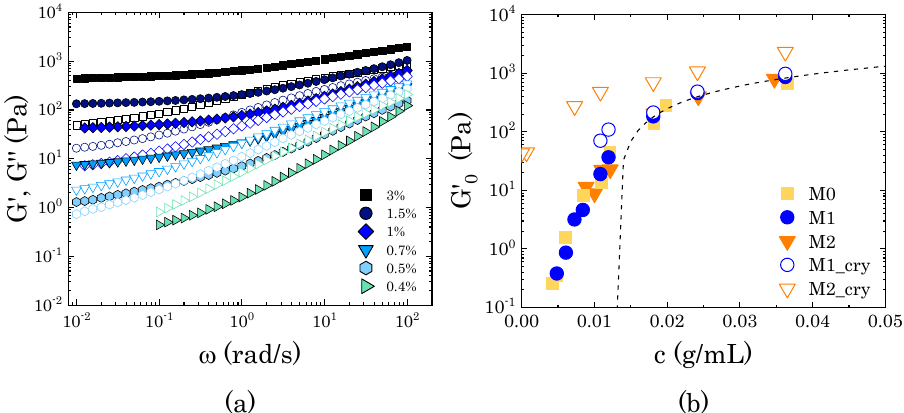
Figure 5. ( a ) Frequency dependence of the storage (closed symbols) and loss (open symbols) moduli at increasing Carbopol concentration. The data refer to samples M0, but the same behaviour was observed for regenerated M1 and M2 solutions. ( b ) Storage modulus, sampled at 1 rad/s, as a function of Carbopol concentration for samples M0, M1, and M2. For the samples containing mannitol, closed symbols indicate regenerated samples, while open symbols indicate samples containing crystals. The = K p ( c − c c ) reported in [25] for black dashed line represents the fitting with the linear relation G (cid:48) 0 the same Carbopol dispersions in pure glycerol. A table reporting the effective mass percentages and corresponding mass concentration for each sample (i.e., M0, M1, and M2) is reported in the Supplementary Materials (Table